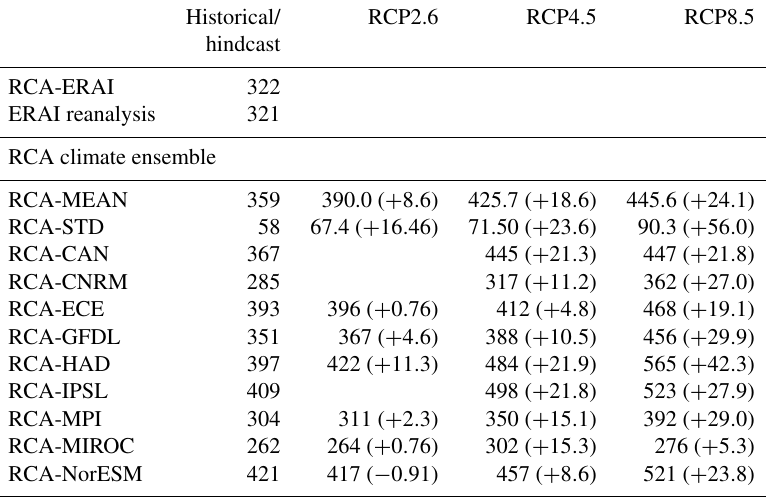
Table 3. Number of ARs detected in a 30-year period of different climate scenarios. The historical period for all runs is 1970–1999. The exception is the ERAI run, for which it was 1979–2008. Numbers in parentheses denote the relative change (%) in the future vs. the historical